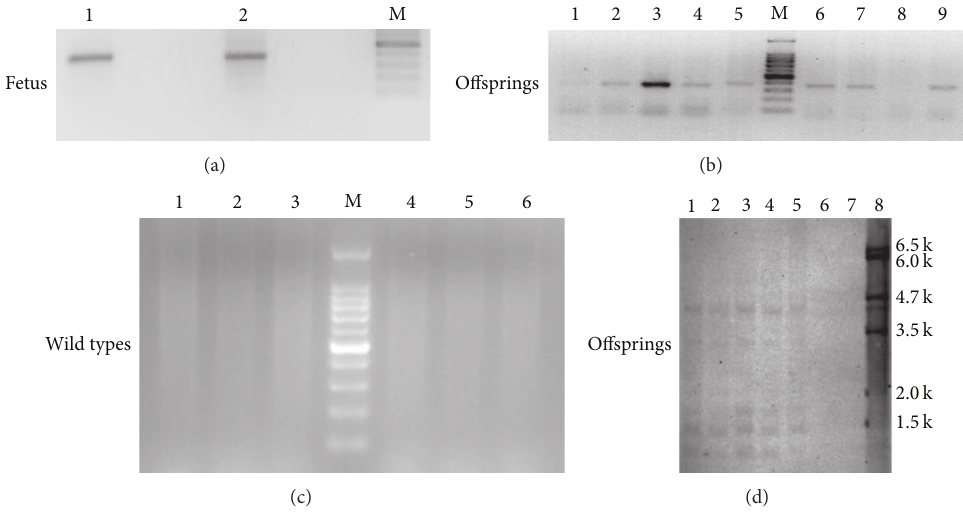
Figure 3: PCR for detection of EGFP gene integrated into the genomes of fetus and offspring. (a–c) Examples of PCR analysis of fetus, offspring and the wild types for detection of EGFP integrated into recipient genomes. There were positive outcomes of 366 bp PCR product in both fetus (a) and offspring (b), but no positive band was found in the wild types (c) which served as the negative control. (d) Southern blot analysis of tail DNA from six offspring, produced from the same recipient mouse and one wild type using a 523-bp PCR product from the control plasmid with primers for EGFP gene as a probe, showing five positive and one negative. Genomic DNA was digested with PstI. Size markers are indicated in the right of southern blot. Lanes 1–6, transgenic mice; lane 7, WT mouse; and lane 8, the control